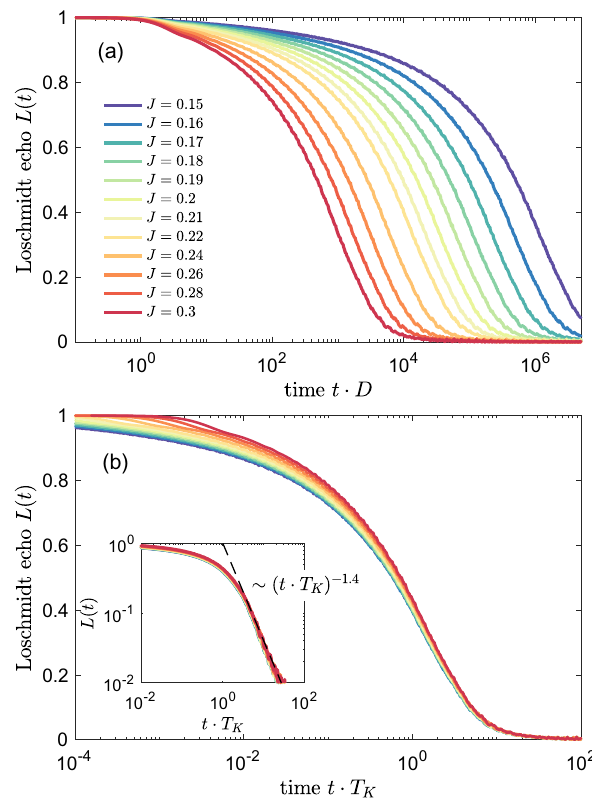
Figure 2. ( a ) The Loschmidt echo L ( t ) for quantum quench in the coupling strength J 1 ≡ J , starting from J = 0 to the value shown in the legend, while J 2 = 0 . ( b ) The Loschmidt echo plotted vs time rescaled with the Kondo temperature T K determined from the halfwidth at half maximum of the impurity’s spectral function. The inset presents the universal behavior for t · T K > 1 , where L ( t ) ∼ ( t · T K ) − 1.4 . We have used the following NRG parameters: number of states kept at each iteration N K = 2048 and the band discretizaton parameter (cid:31) = 1.3 , while J is expressed in terms of band halfwidth D ≡ 1